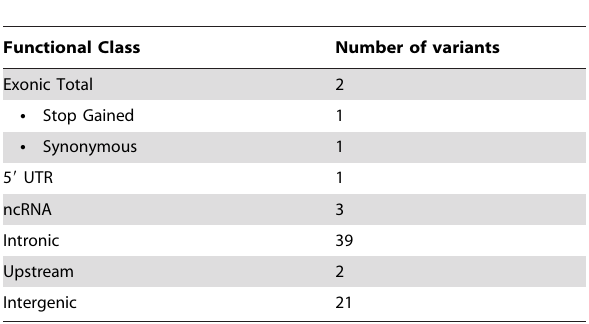
Table 3. Number of candidate variants per functional class.